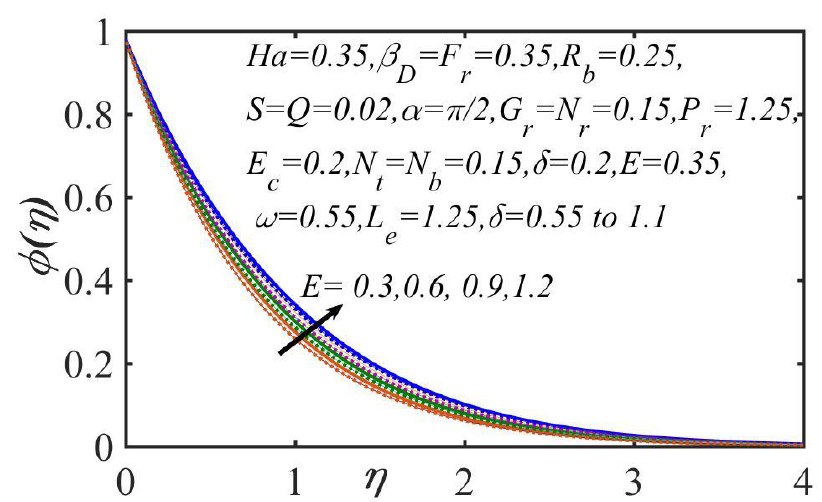
Figure 12. Influences of 𝐸 and 𝛿 on the concentration magnitudes. Solid curve: 𝛿 = 0.55 ; dotted curve: 𝛿 = 1.1 .